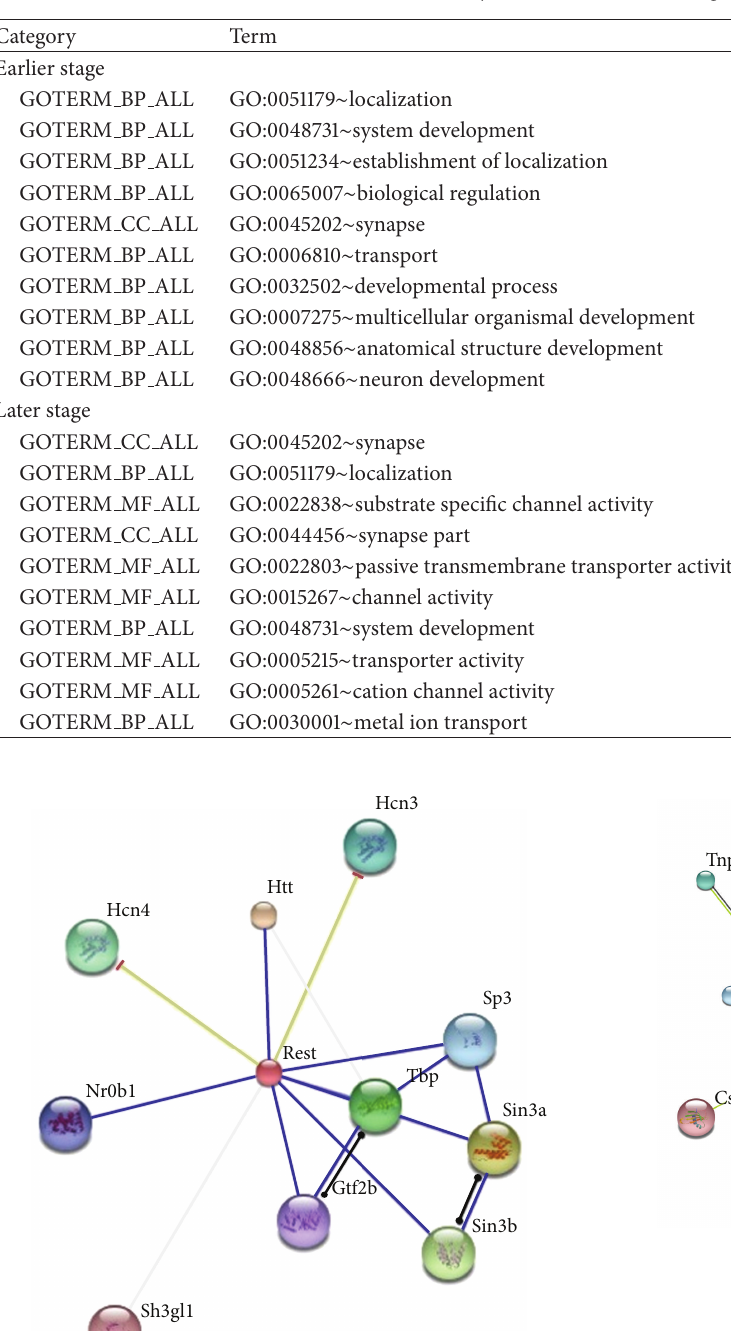
healing after femoral fracture. Besides, Syt1 might control neural signal transmission combined with SNAP-25 [37, 38] Figure 3: The PPI network of Rest gene. and STX1A [39]. STX1A was involved in vesicle fusion process which is critical for calcium-dependent neurotransmitters release. Importantly, it has been reported that increase of Syt- 1 might play a role in impairment of learning and memories attributed to aging in mouse model